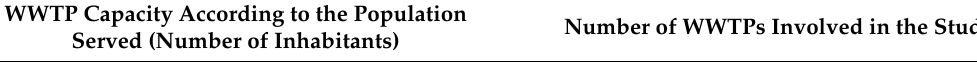
Table 1. The overview of the selected WWTPs according to the population